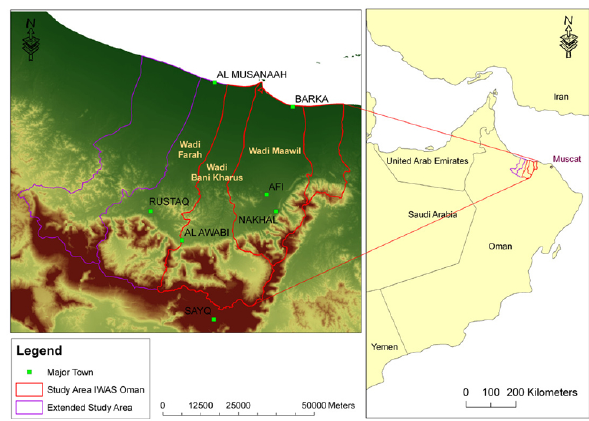
Fig. 3. The study area in the northern